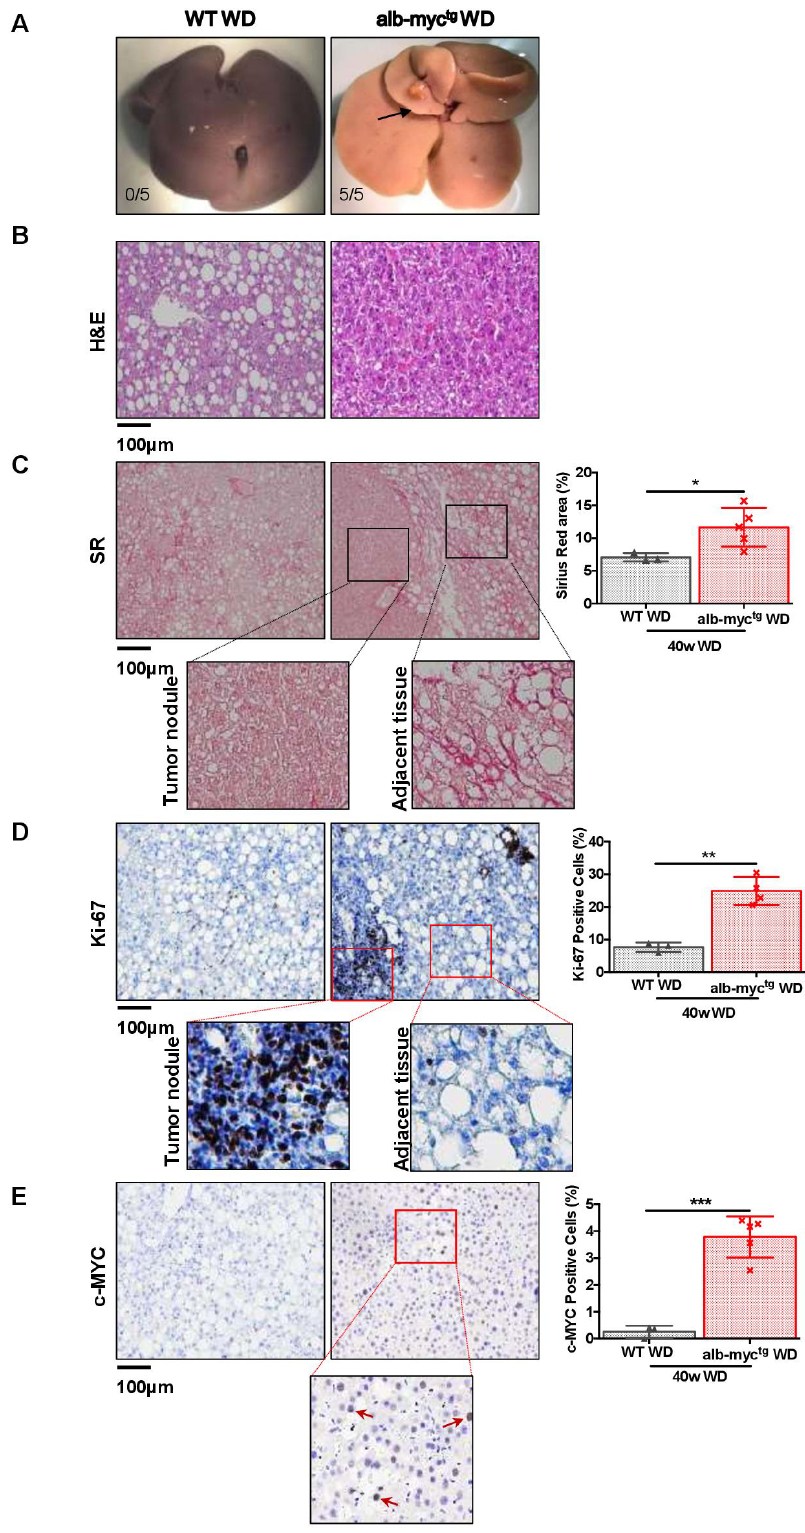
Figure 6. WD feeding accelerates the initiation of MAFLD associated tumorigenesis in alb-myc tg mice. WT ( n = 3) and alb-myc tg ( n = 5) mice fed 40 weeks with WD. ( A ) Gross liver. Numbers represent tumor incidence. ( B ) Representative liver sections stained with H&E. ( C ) Representative liver sections stained with SR. Quantification of % SR positive area ( n = 3–5) Scale bar = 100 µ m. ( D ) Ki-67 immunostaining of paraffin sections showing increased cell proliferation (brown) of hepatocytes